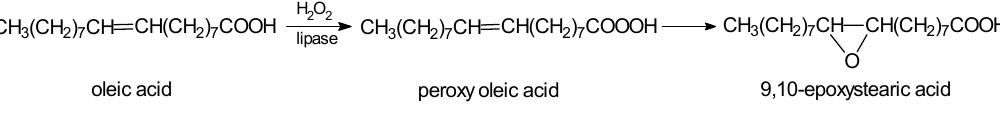
Scheme 1. Chemo-enzymatic self-epoxidation of unsaturated fatty acids: conversion of oleic acid to epoxystearic acid.